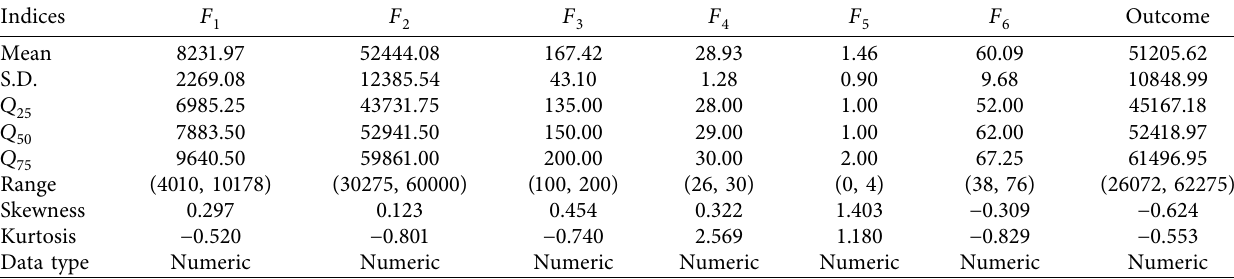
Table 2: Statistical description of influence features for forecasting the